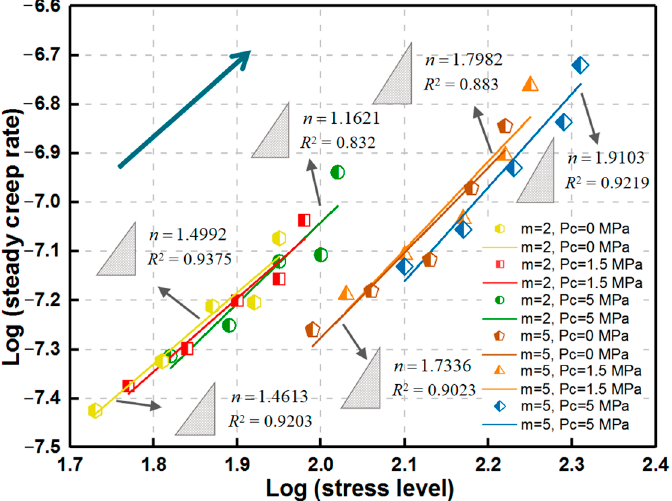
Figure 11. Relationship between stress level and steady creep rate for various homogeneity indexes during triaxial creep loading.